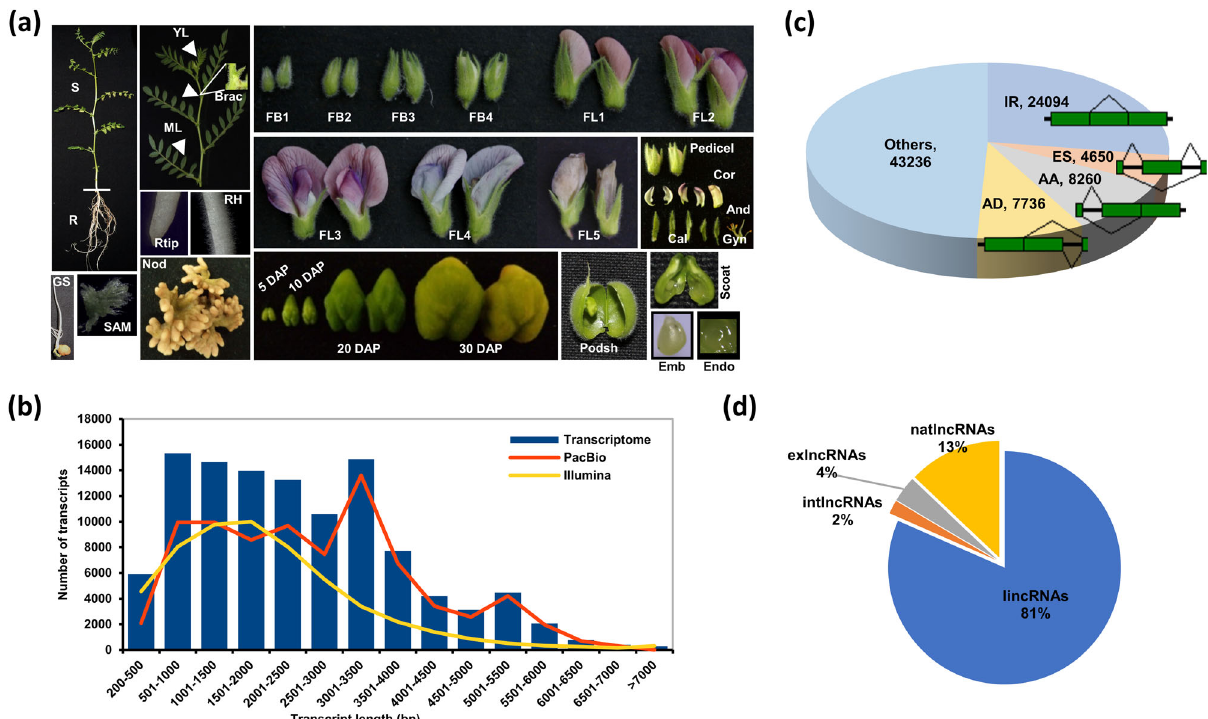
Fig. 1 Sequencing and analyses of chickpea full-length transcriptome. a Different tissues/organs used for generation of RNA-sequencing data using Illumina platform. GS germinating seedling, S shoot, ML mature leaf, YL young leaf, Brac bracteole, R root, Rtip root tip, RH root hair, Nod nodule, SAM shoot apical meristem, FB1 – FB4 stages of fl ower bud development, FL1 – FL5 stage of fl ower development, Cal calyx, Cor corolla, And androecium, Gyn gynoecium, Pedi pedicel, Emb embryo, Endo endosperm, SdCt seed coat, PodSh podshell, 5DAP seed 5 days after pollination, 10DAP seed 10 days after pollination, 20DAP seed 20 days after pollination, 30DAP seed 30 days after pollination. b Length distribution of transcripts in the fi nal transcriptome assembly and the transcripts generated via PacBio sequencing and reference-based assembly of Illumina data alone from 32 tissue samples. c Pie-chart showing the fraction of different types of major alternative spliced events (IR intron retention, ES exon skipping, AA alternate acceptor, AD alternate